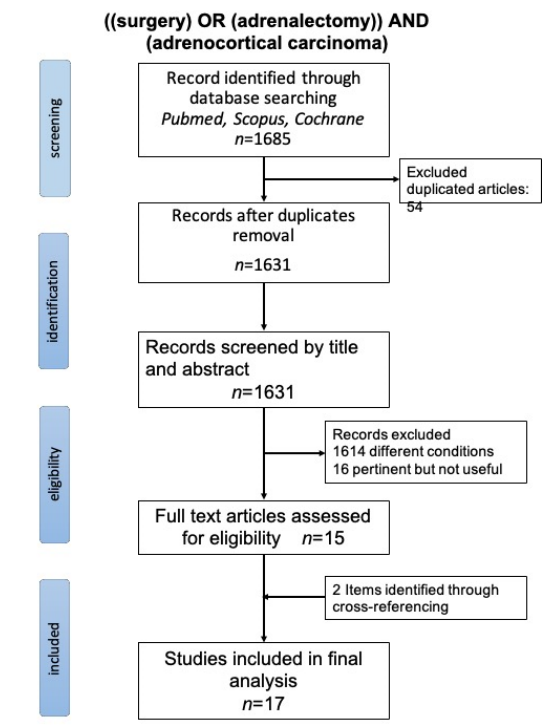
Figure 2 . Prisma flowchart . Figure 2. Prisma